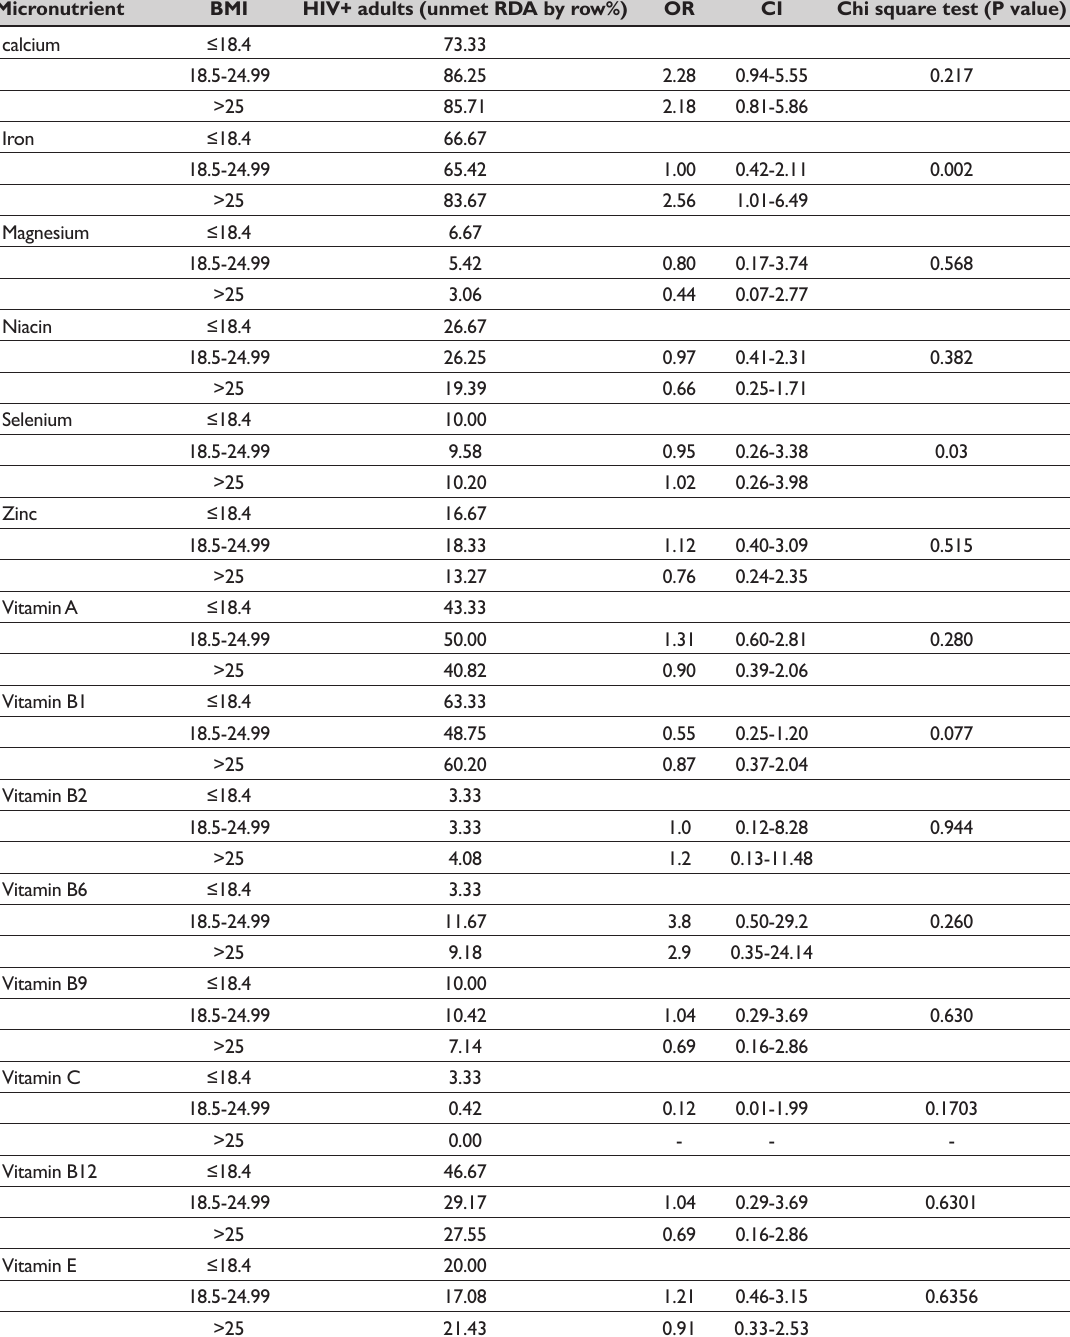
Table 2: Bivariate analysis for micronutrient intake by BMI among HIV+ patients initiating HAART